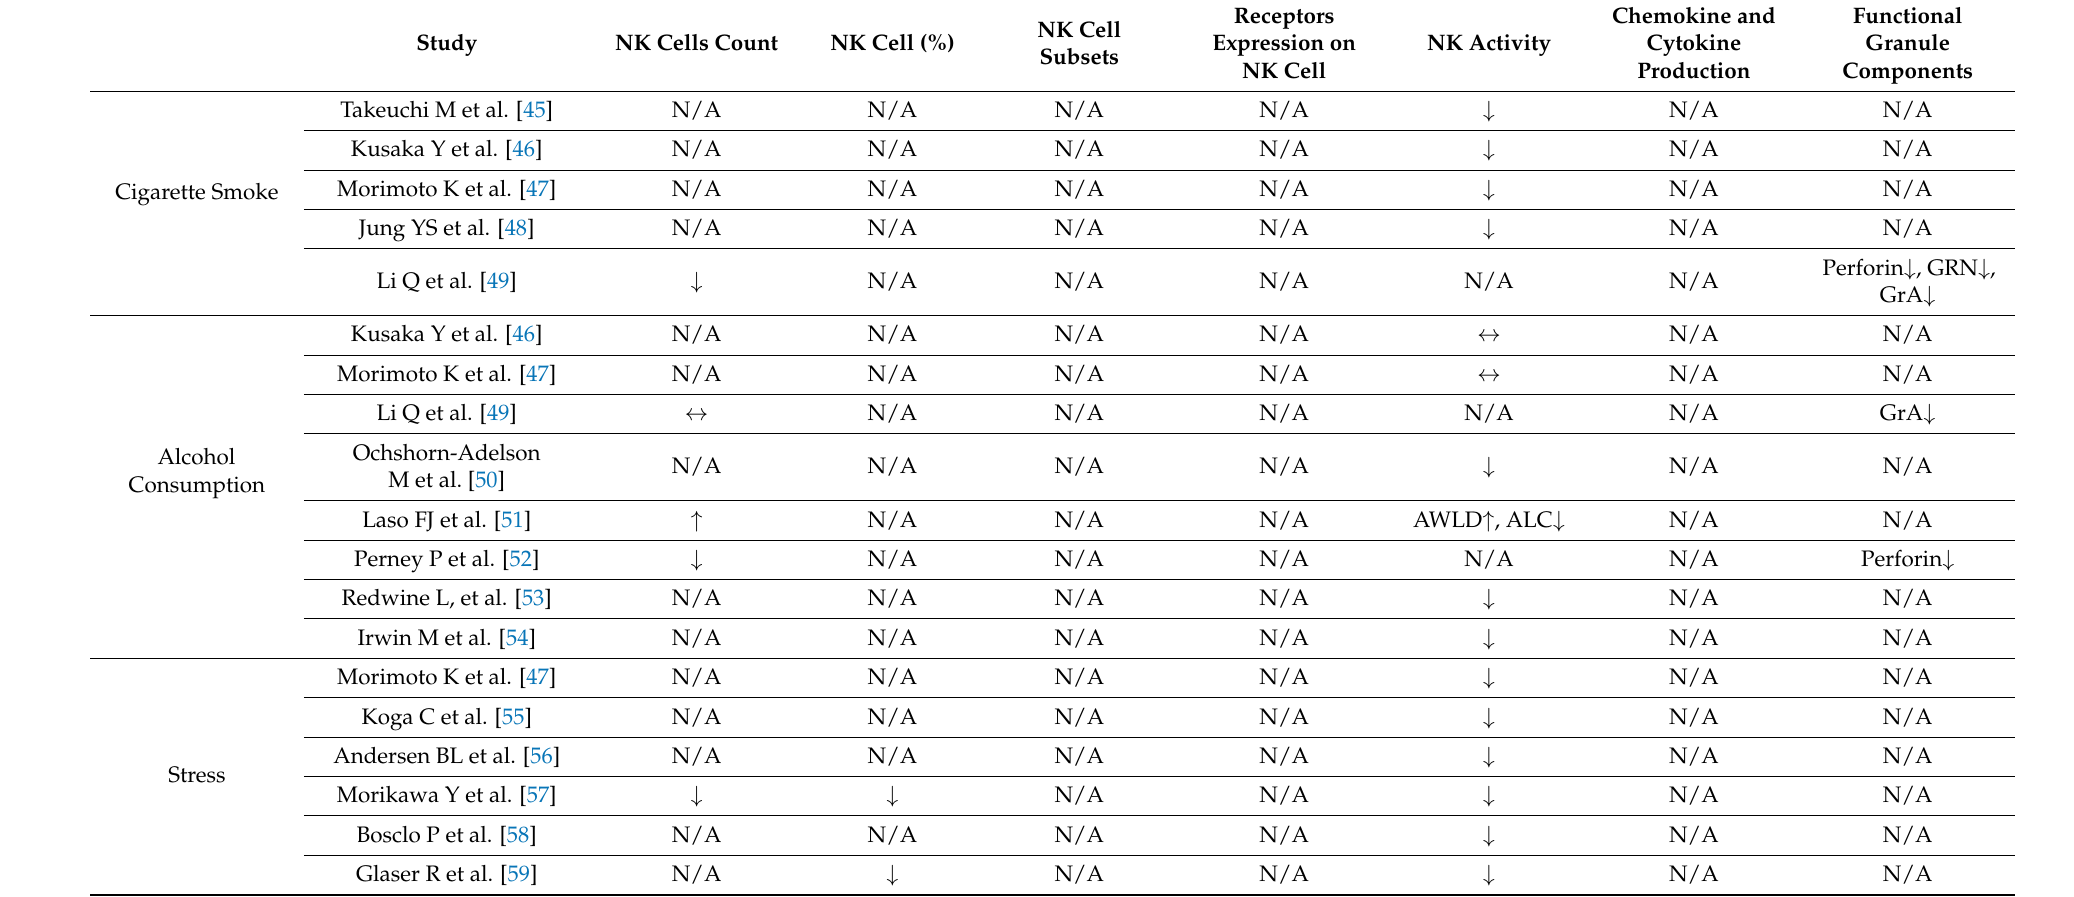
Table 1. Overview of Lifestyles Associated Alterations of Human NK